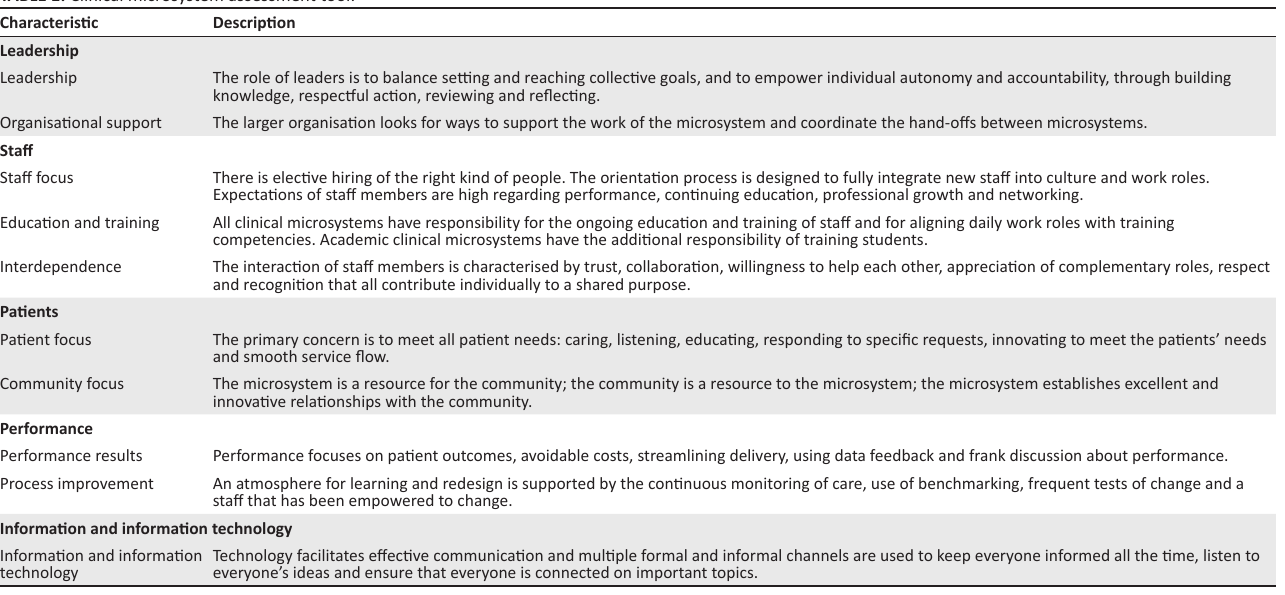
TABLE 1: Clinical microsystem assessment